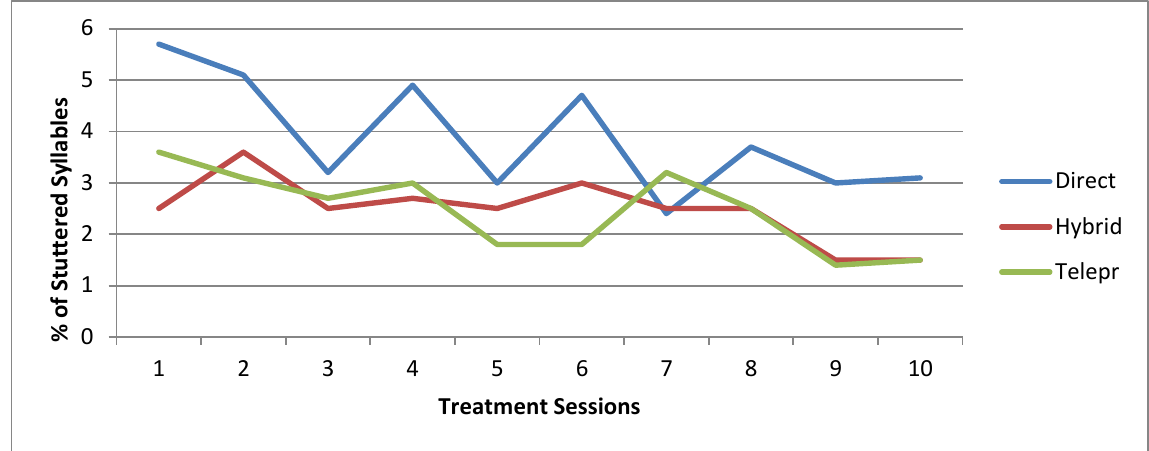
Figure 6. Participant 2: Percentage of stuttered syllables across intervention periods (Telep=